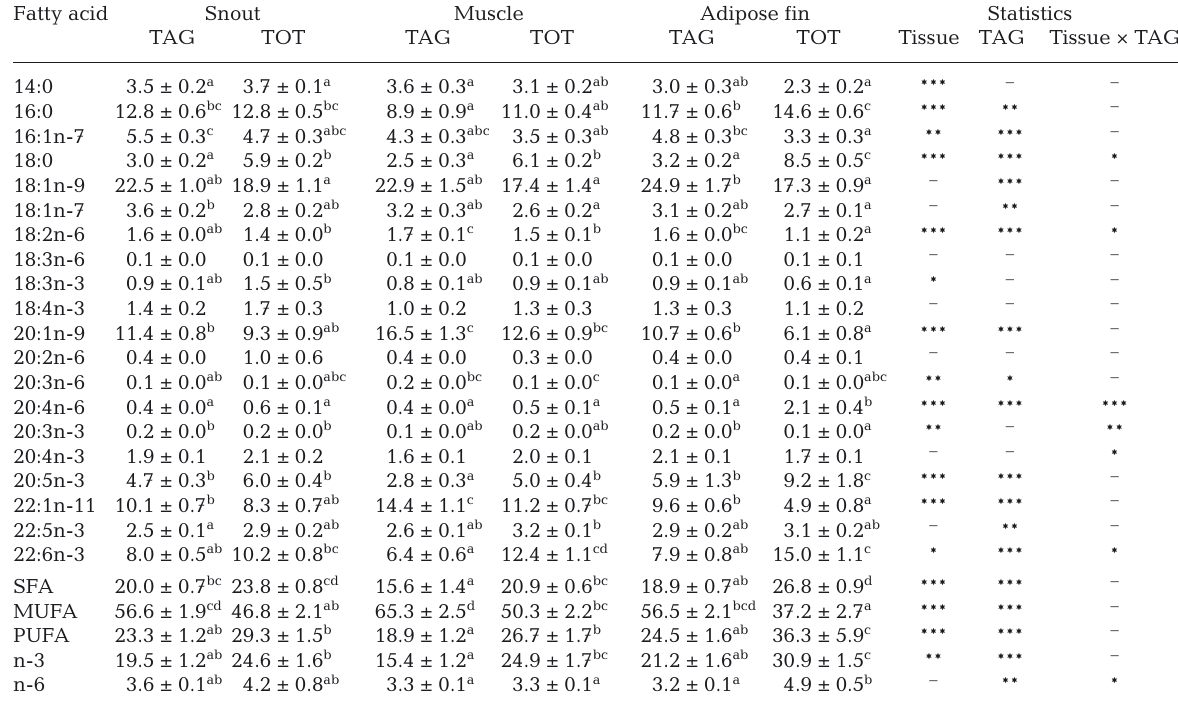
Table 3. Salmo salar . Fatty acid composition in the snout, muscle and adipose fins triacylglycerols (TAG) and total lipids (TOT) of wild Atlantic salmon caught upon entering the Dale River (percent of fatty acids). Data are means (±SEM) of 9 fish. Potential differences between the tissues were assessed by 2-way ANOVA and Tukey’s post hoc test. Main effects are given in right columns—tissue: effect of adipose fin, snout and muscle; TAG: effect of TAG or TOT fatty acid methyl ester composition; Tissue × TAG: interaction of the 2; SFA: saturated fatty acids; MUFA: monounsaturated fatty acids; PUFA: polyunsaturated fatty acids. Significance was accepted at p < 0.05. Numbers within each line not sharing common superscript letters